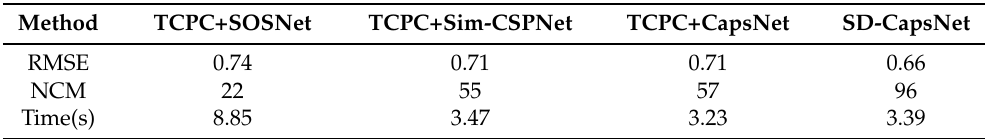
Table 7. Quantitative comparison of feature descriptor matching with different feature descriptor ex-